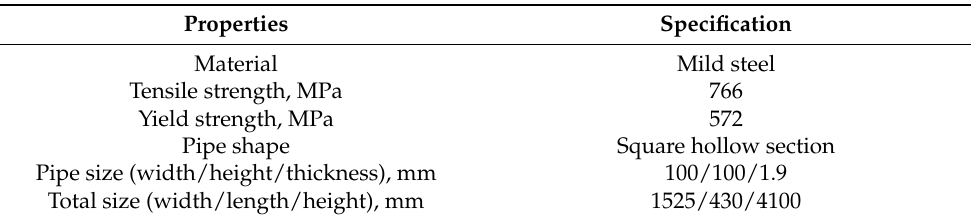
Figure 2. Schematic diagram of wooden cross-arm used in creep test rig.